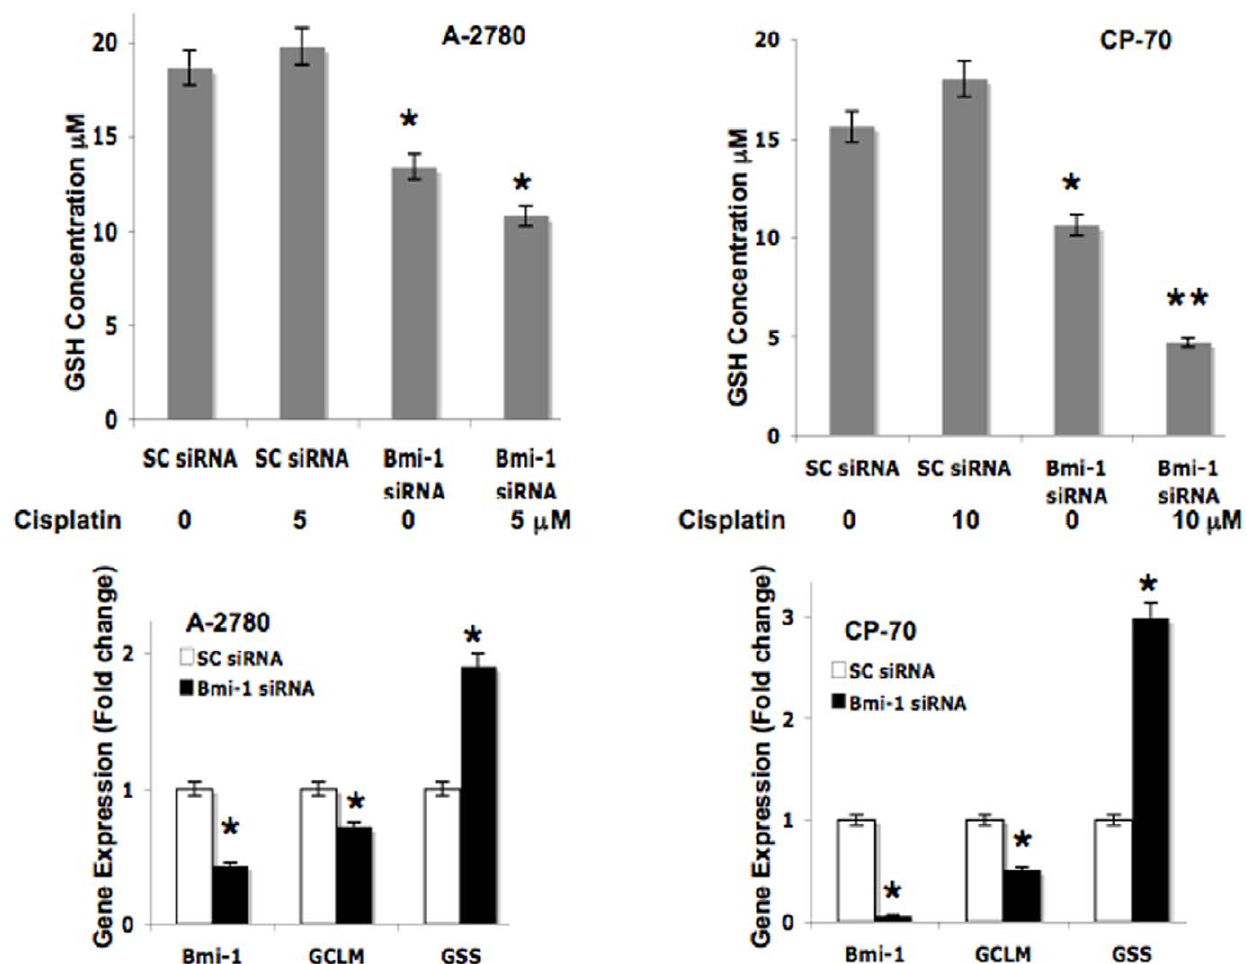
Figure 3. Bmi-1 knockdown perturbs the GSH biosynthesis pathway. The top panel represents total cellular GSH measured (Materials and methods) in ovarian cancer cells transfected with scrambled control or Bmi-1 siRNA treated with or without cisplatin for 24 h. The bottom panel represents fold change in gene expression (normalized with beta actin and compared to scrambled control) as determined by quantitative RT-PCR of ovarian cancer cells transfected with scrambled control or Bmi-1 siRNA for 48 h.